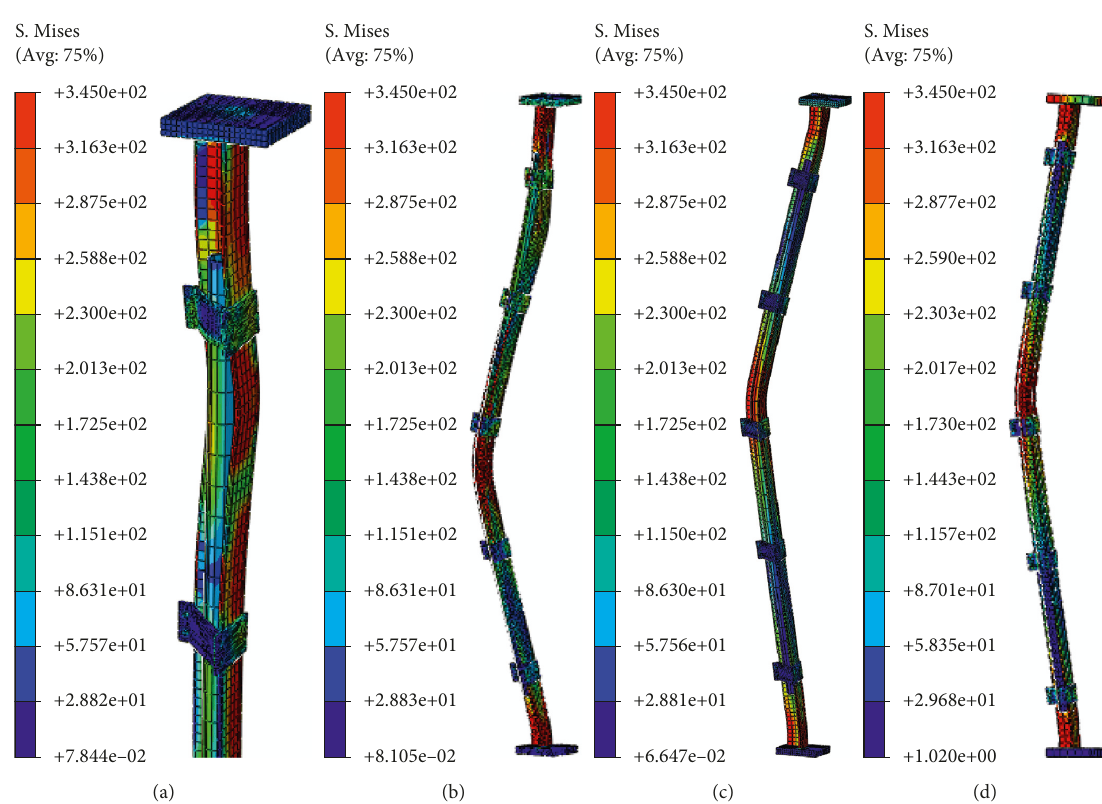
Figure 16: Buckling patterns of different steel pipe members. (a) L100 × 10G70SR75-575. (b) L100 × 10G57SR75-575. (c) L100 × 10G50SR75-575. (d) L100 ×